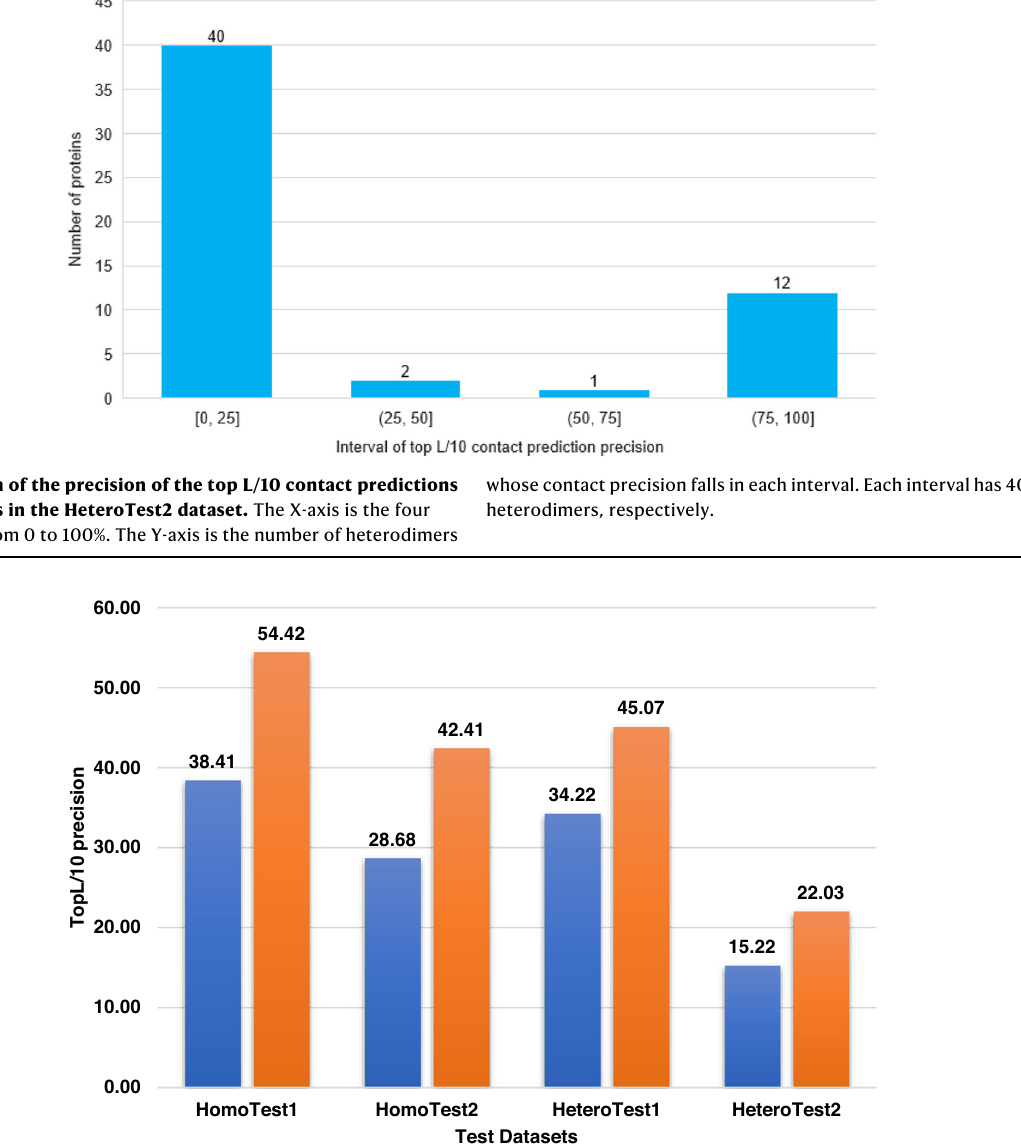
Fig.2|ComparisonbetweenCDPred_PLM(blue)andCDPred_ESM(orange)onfourdifferenttestdatasets. They-axisisthetopL/10contactpredictionprecision,and the x-axis is the four different test